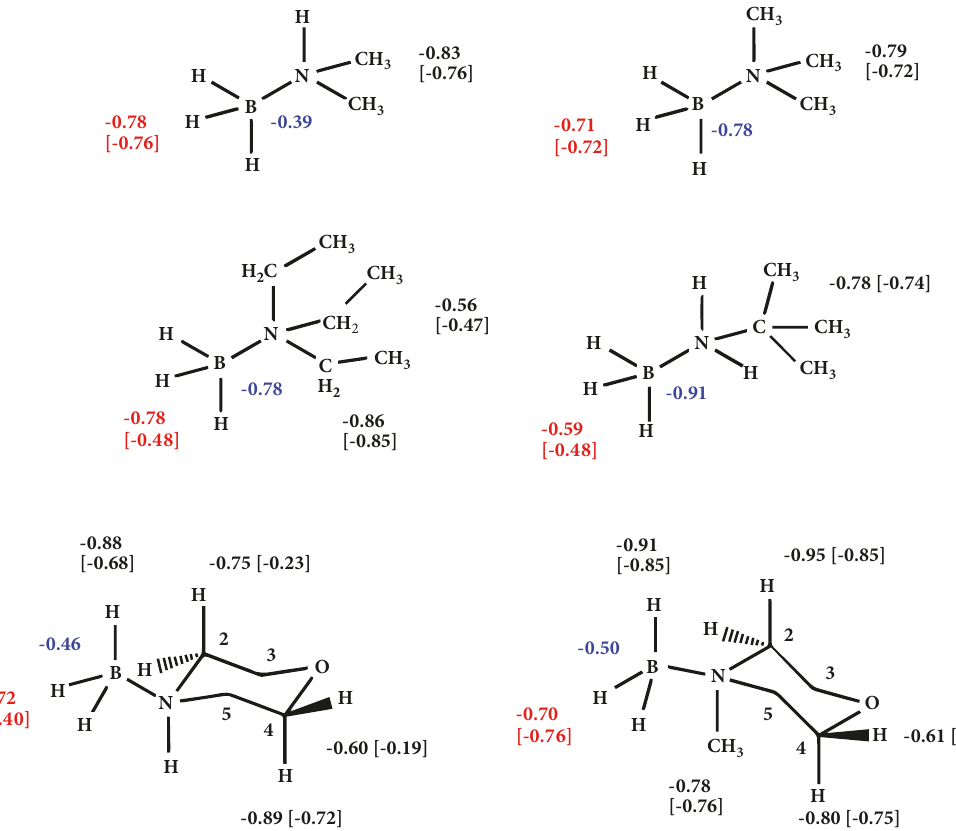
Figure 2: Structures of amine borane guests (R 3 NBH 3 ) with the limiting chemical shift changes ( (cid:2) 𝛿 black and B-H in red) and boron (blue) resonances upon complexation by CB [7] . The values in the square brackets are the (cid:2) 𝛿 the corresponding quaternary alkylammonium cations (R 3 NCH 3+